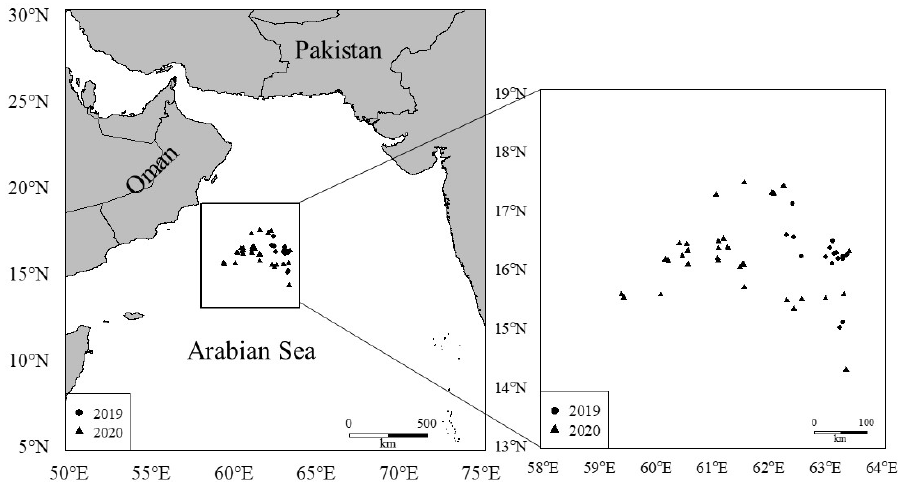
Figure 1. Sample localities of S. oualaniensis in the northwest Indian Ocean. Table 1. Basic information of female and male S. oualaniensis specimens collected in different years in the northwest Indian Ocean.